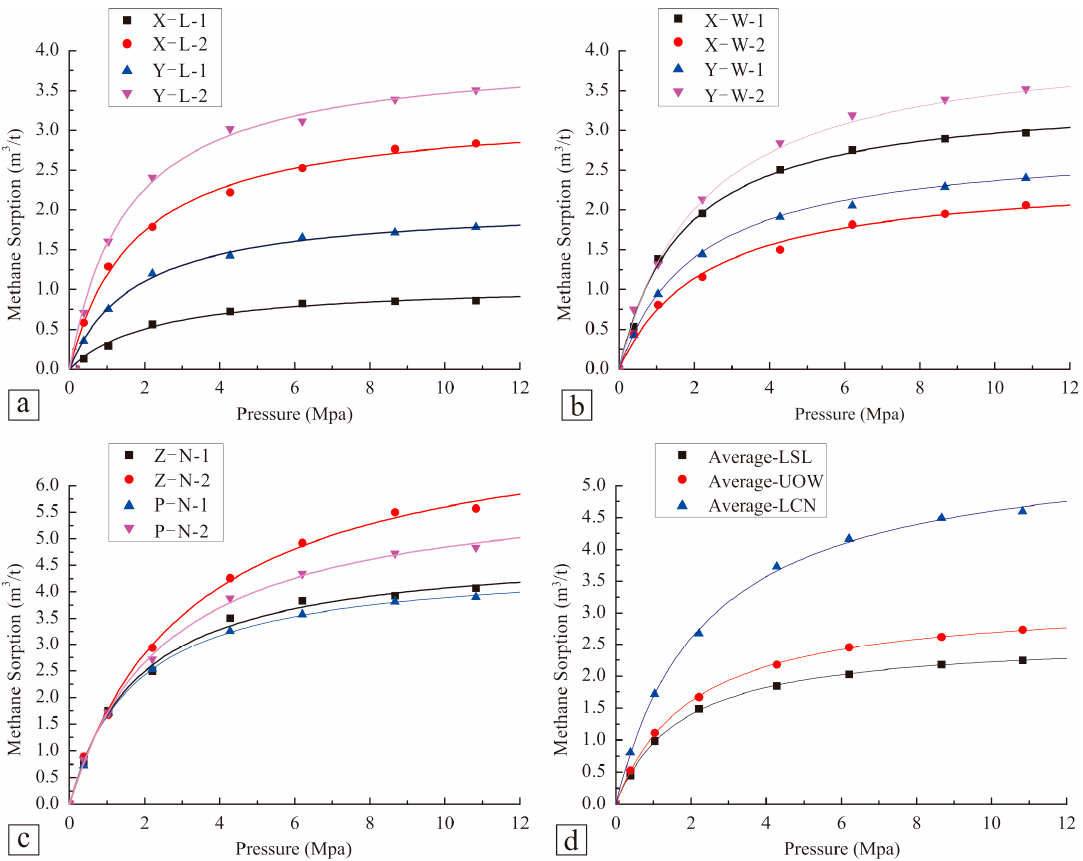
Figure 10. Langmuir isothermal adsorption curves of the selected shales. ( a ) LSL shale; ( b ) UOW shale; ( c ) LCN shale; ( d ) average statistics.